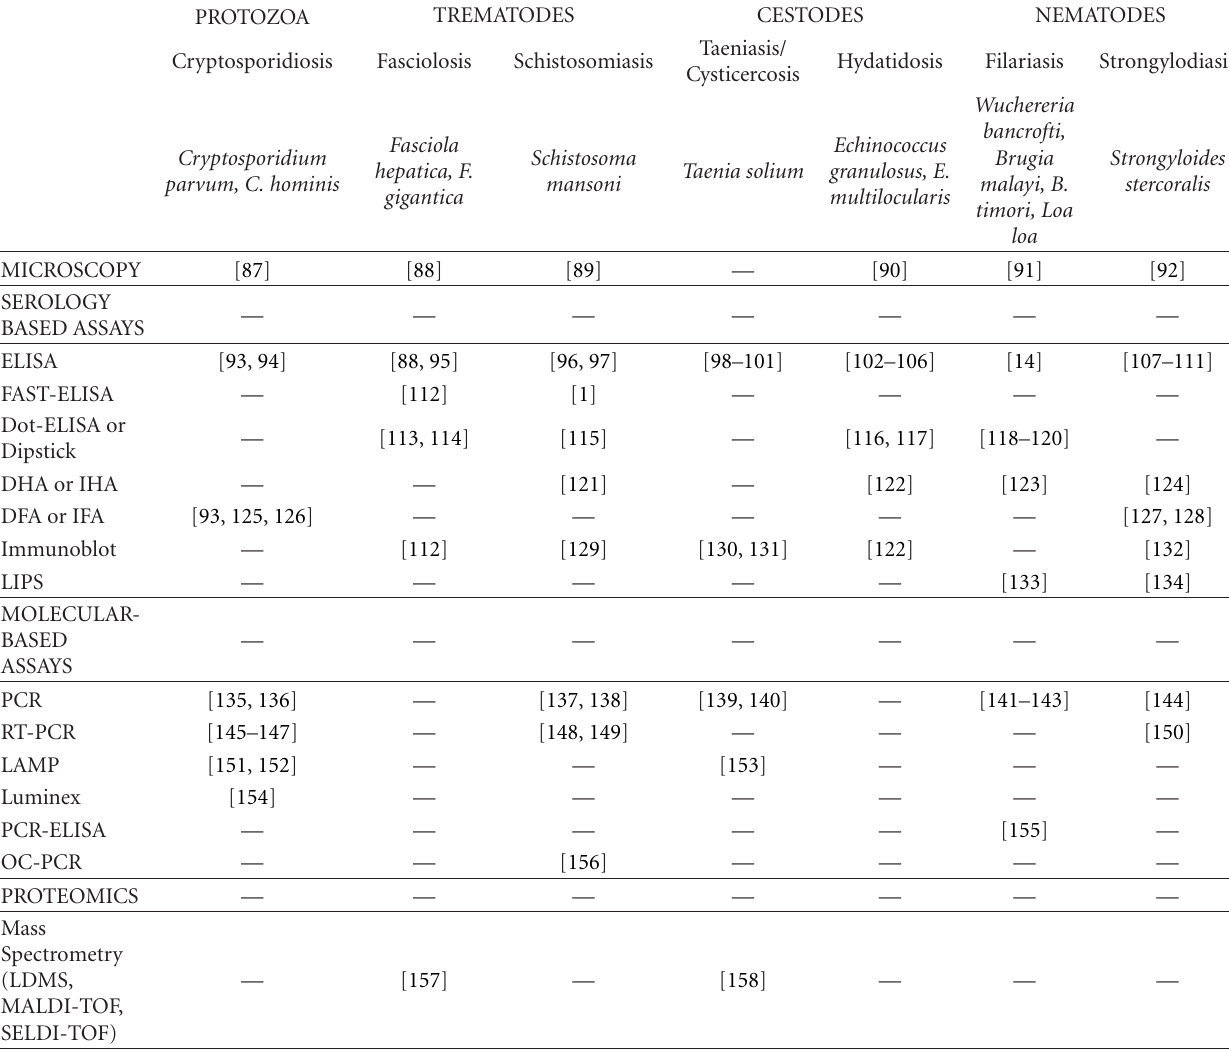
Table 2: Diagnostic tools for the detection of specific intestinal parasitic diseases.